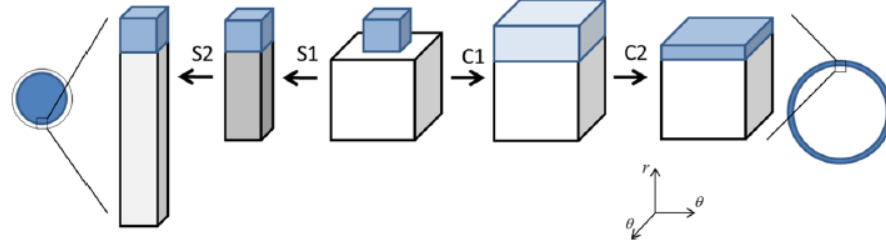
Figure 9. ( a ) Hysteresis in the surfactant-induced volume phase transition. The gel volume shows a jump transition at a critical surfactant concentration in the equilibrium reservoir solution, which is di ff erent for the swelling and collapse transitions; ( b ) comparison of experimental and theoretically calculated surfactant concentrations at VPT at di ff erent salt concentrations. Symbols: experimental data taken from Figure 2 (open circles: collapse transition; filled circles: swelling transition). Solid curves: theory (arrows up and down indicate the curves for collapse and swelling transition, respectively). Dashed curve: Maxwell transition. Thin dotted line: the calculated critical micelle concentrationin the liquid. Figures taken from ref. [68]. Reprinted with permission. Copyright 2015 American Chemical Society.